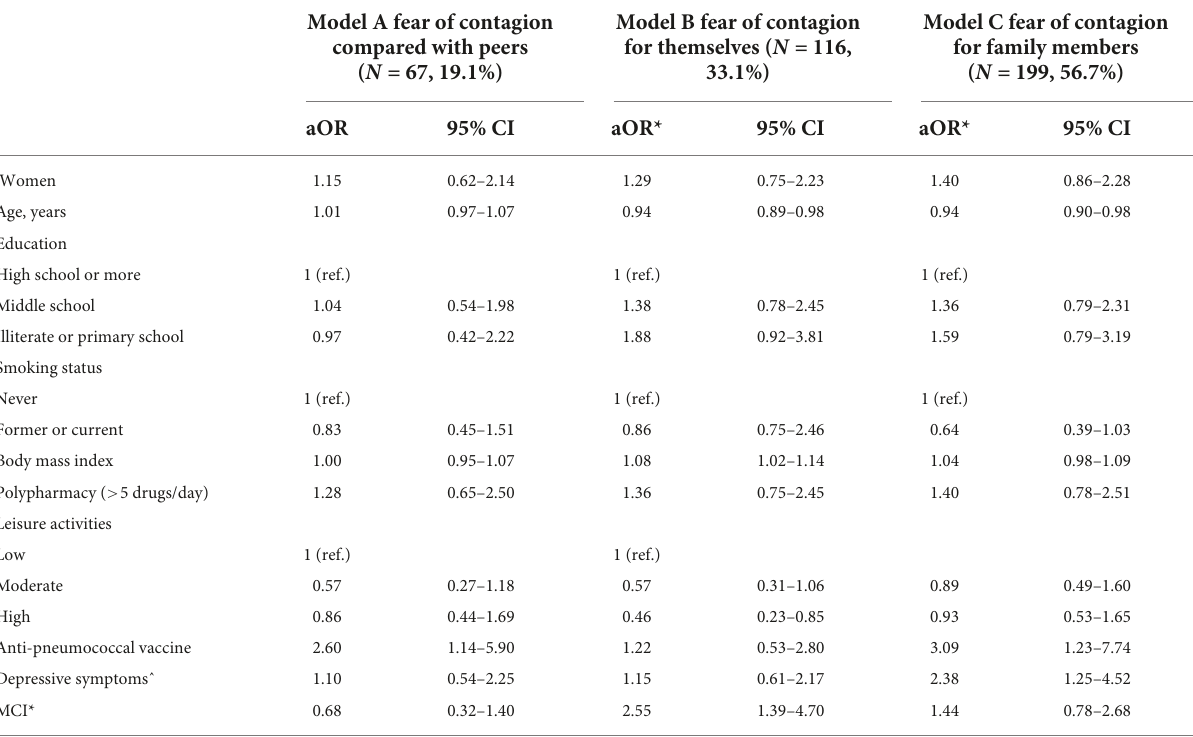
TABLE 4 Binary logistic regression model between baseline characteristics of participants and fear of contagion (medium-high fear vs. no or low fear) compared with peers (model A), for themselves (model B, and for family members (model C). Model A fear of contagion compared with peers ( N = 67,